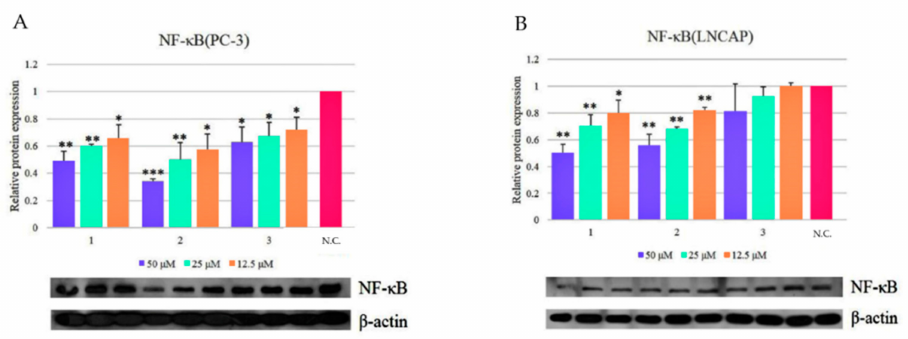
Figure 2. NF-kB inhibitory activities of oregonin ( 1 ), hirsutenone ( 2 ), and hirsutanonol ( 3 ) in PCa cell lines. A: PC-3 cell; B: LNCaP cell. The results were expressed as mean ± SD of triplicate experiments ( n = 3). NC: Normal control group. *: p < 0.05, **: p < 0.01, ***: p < 0.001, compared with the normal control group.